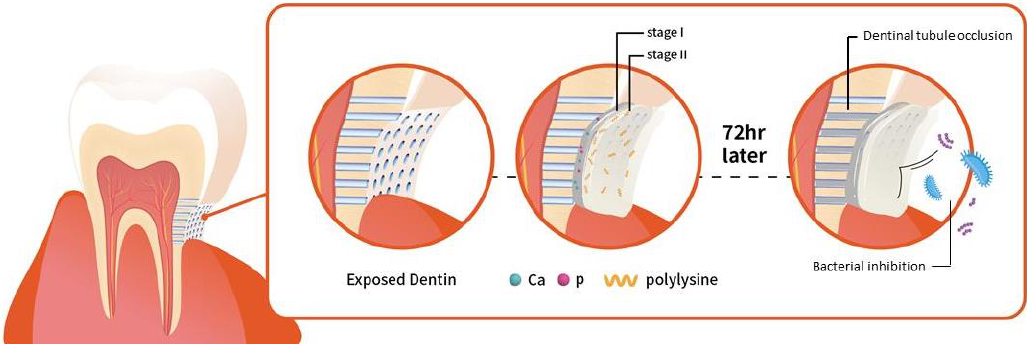
Figure 1. Schematic demonstration of the two steps tooth coating material inducing effective dentinal tubule occlusion and bacterial inhibition.